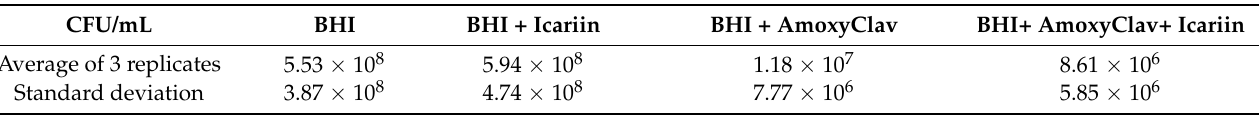
Table 2. CFU/mL of S. aureus after 3 h incubation in BHI liquid media (control) or BHI liquid media supplemented with icariin, AmoxyClav, or